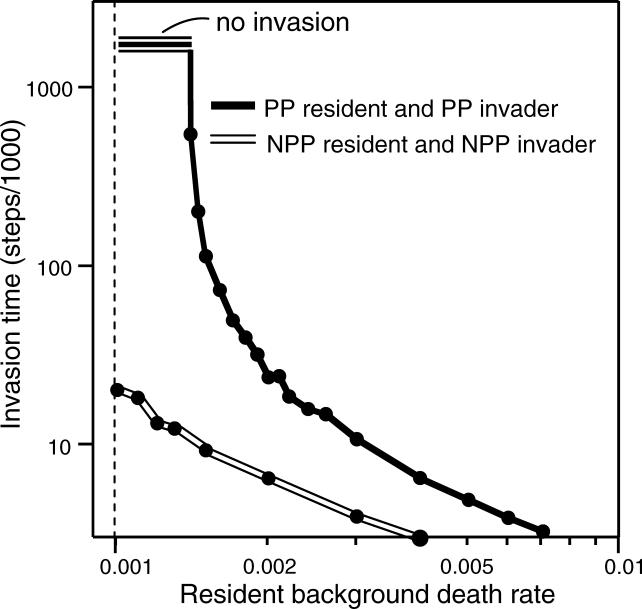
Effect of Plasticity on Invasion TimeMean invasion time (number of steps, log scale) as a function of the background death probability of the resident species, for cases in which the resident and invader both did (PP, solid line) or did not (NPP, empty line) exhibit phenotypic plasticity. The foraging strategy of the individuals from the invader and resident species differed due to different evolutionary histories (Figure 1). Other than this difference, the only difference between individuals from the invader and resident species was their background death probability. Here we show results in which the invader has the default background death probability, equal to 0.001, and that of the resident increases from 0.001 (in which case there is no imposed competitive difference) to 0.01 (in which case the invader has a strong imposed competitive advantage). As expected, the invasion time decreased in both cases (PP and NPP) as the imposed competitive advantage of the invader was increased. Unexpected, however, is that invasion was much slower if both the resident and invader exhibited phenotypic plasticity than if they did not. Note that for a range of background death probability values, from 0.001 to about 0.0015 in which there was an imposed competitive advantage of the invader, there was no invasion with phenotypic plasticity, but there was invasion without phenotypic plasticity.